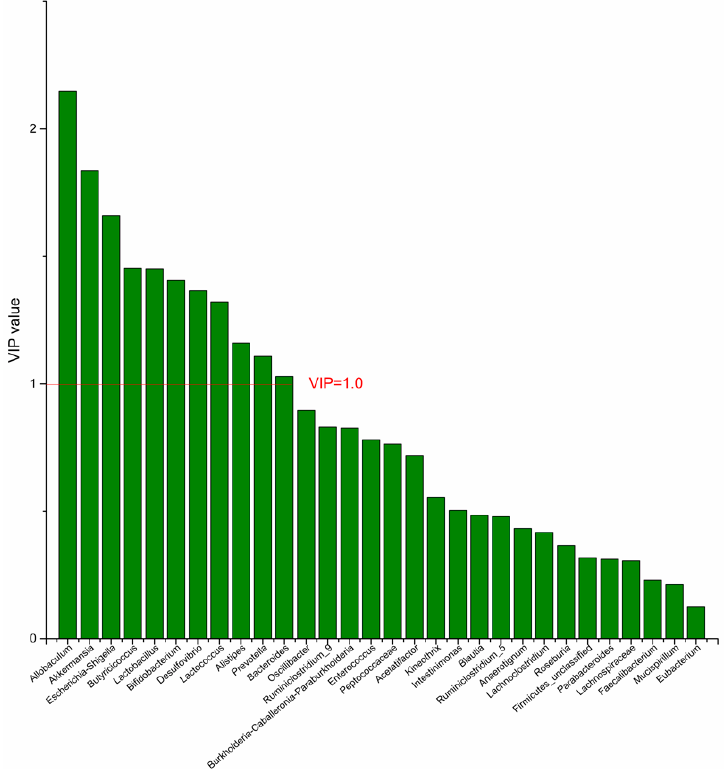
Figure 7. The VIP plot of the differential bacterial genera in DPA group vs. MC group.